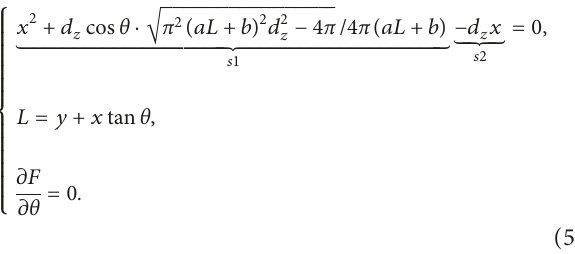
Figure 2: Arc combined spool